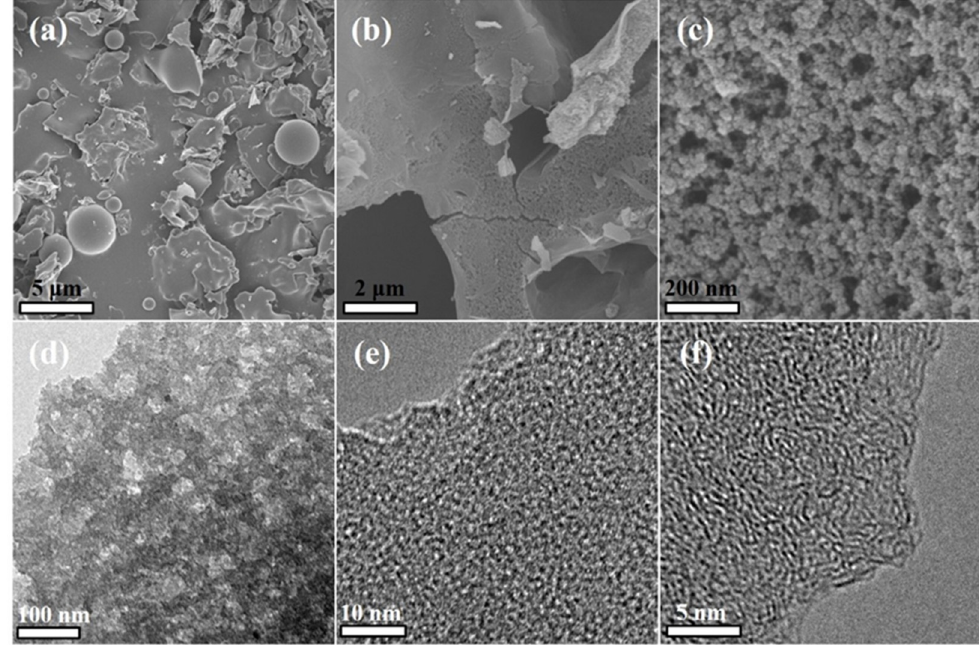
Figure 3. SEM images of ( a ) GO(0.25)/MR and ( b , c ) GO(0.25)/MR-500, ( d ) TEM image and ( e , f ) high- resolution TEM image of GO(0.25)/MR-500.